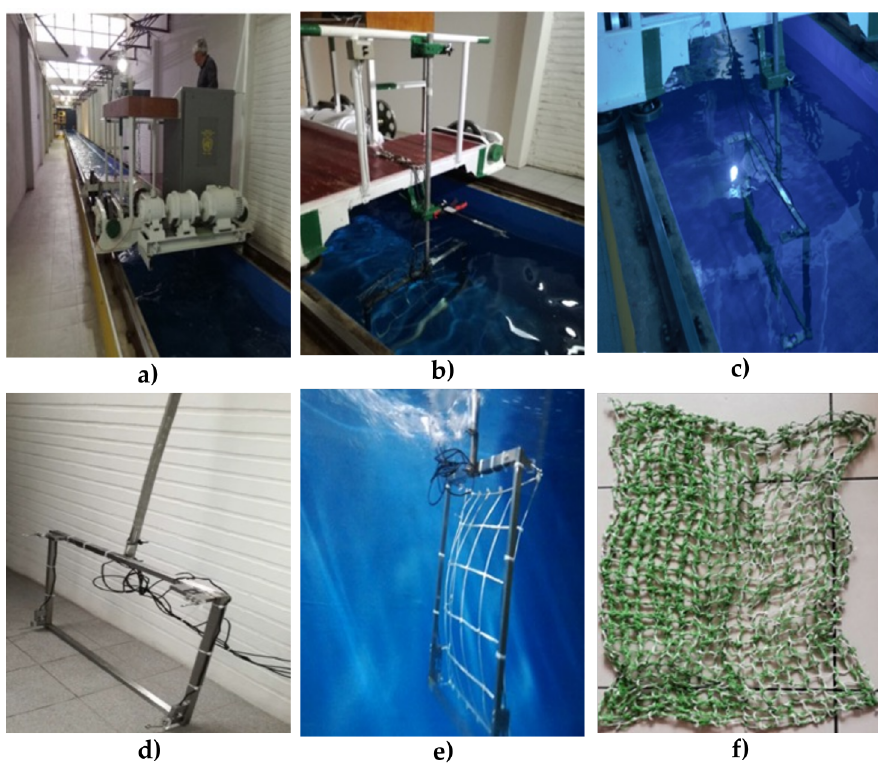
Figure 1. ( a ) Trailer carriage; ( b ) racket attached to the carriage during normal drag force test; ( c ) racket attached to the carriage during tangential drag force test; ( d ) racket without a net; in their vertices load cells are located; ( e ) racket during normal drag force test; the image shows the clean sea lion net; ( f ) fish net with 45% fouling.